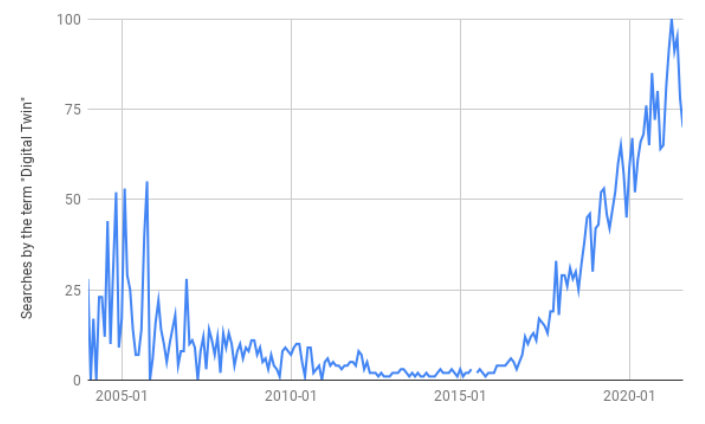
Figure 1. Search for the term “Digital Twin” in Google. Source: Google Trends (www.google.com/ trends, accessed on 2 March 2022).